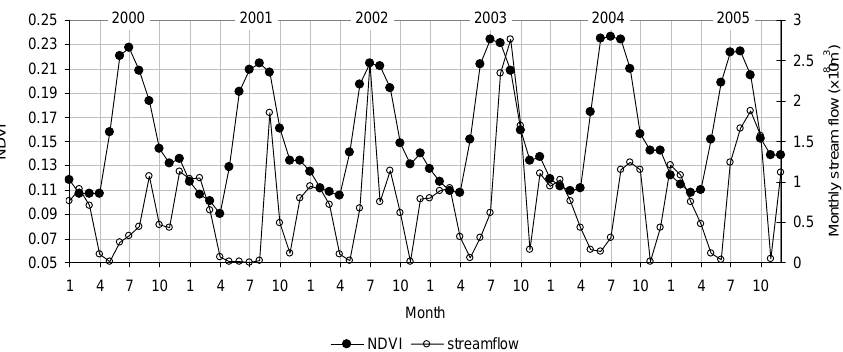
Fig. 8. Monthly total river streamflow at the Zhengyixia hydrological station and the area-averaged monthly NDVI between 2000 and 2005 in the Ejina Oasis.